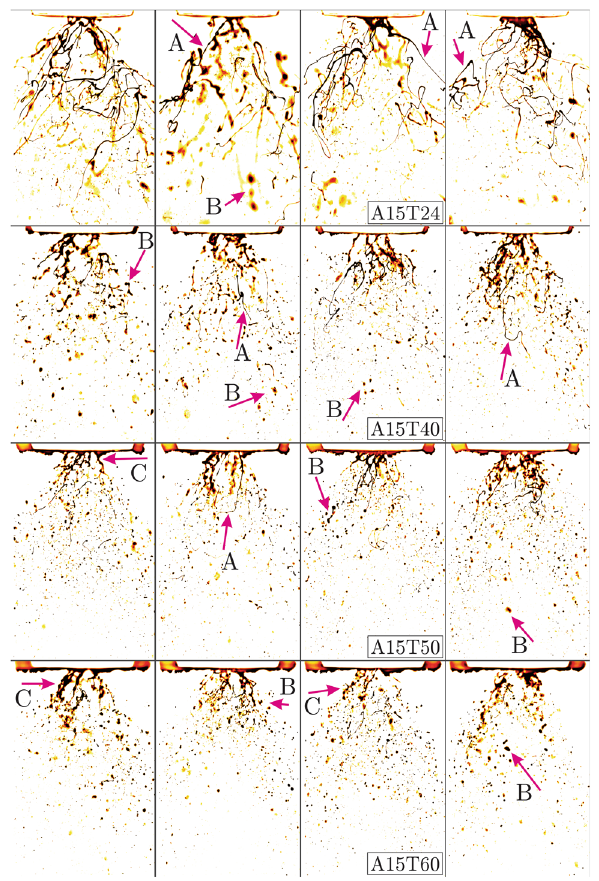
Figure 4. Bio-oil injected at the preheating temperatures of T = 24, 40, 50, 60 ( ◦ C) ( T 24, T 40, T 50 and T 60), liquid flow rate of q f = 1.8 (kg/h) ( L 04 cases at 4 (lb/h)) and air flow rate q a = 15 (l/min) ( A 15 cases). (FOV: 9.43 d